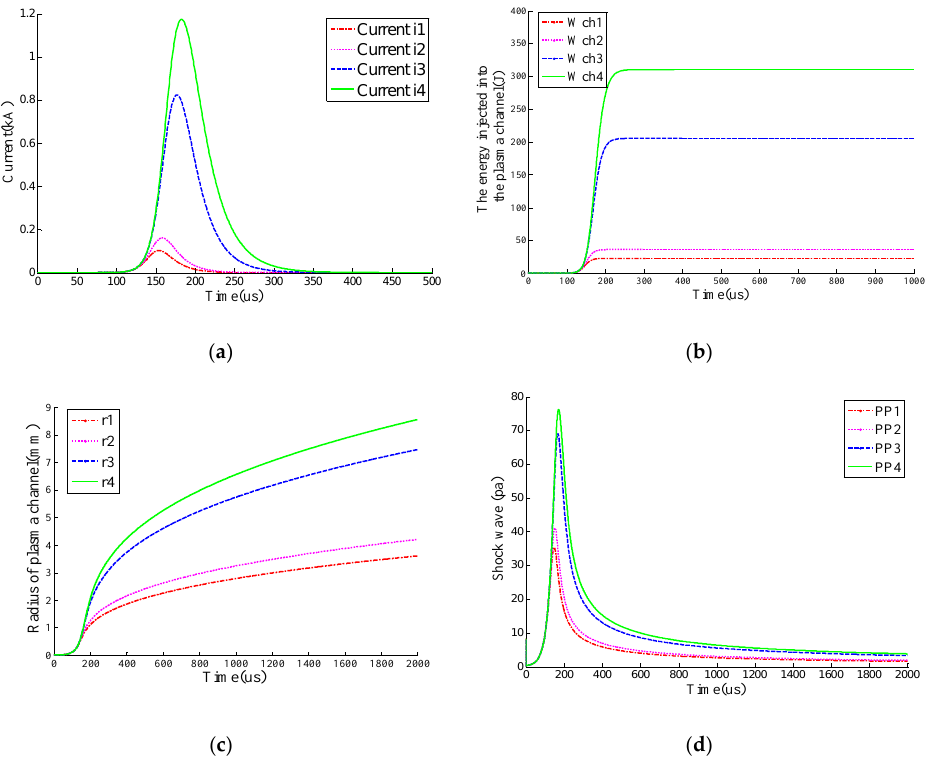
Figure 8. ( a ) Current waveform of plasma channel, ( b ) the energy injected into the plasma channel, ( c ) radius of plasma channel, and ( d ) shock wave. L = 5 μH , U = 10 kV, C ( μF ): C1 = 0.5, C2 = 0.8, C3 = 5, C4 = 8.